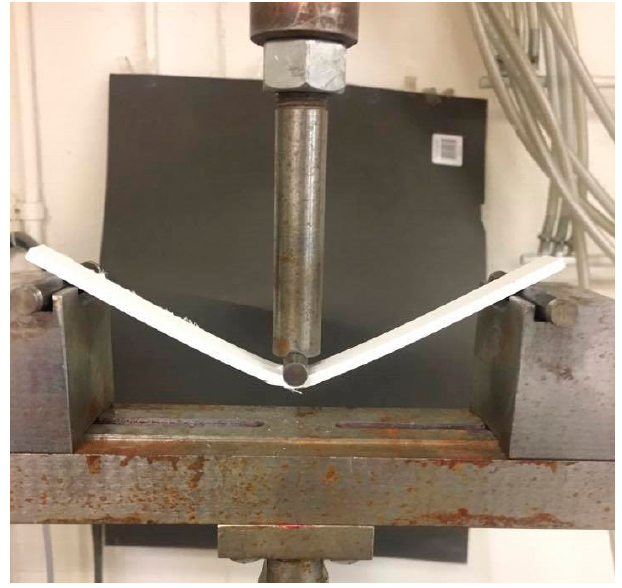
Figure 4. Three-point bending experimental setup with fractured specimen.